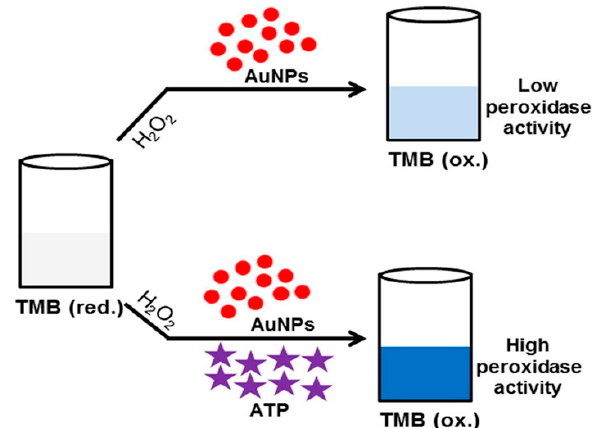
Figure 13. The schematic illustration of the colorimetric sensing mechanism for adenosine triphosphate (ATP) based on the ATP-promoted nanozyme activity of AuNPs. Reproduced with permission from Reference [138]. Elsevier B.V., 2015.